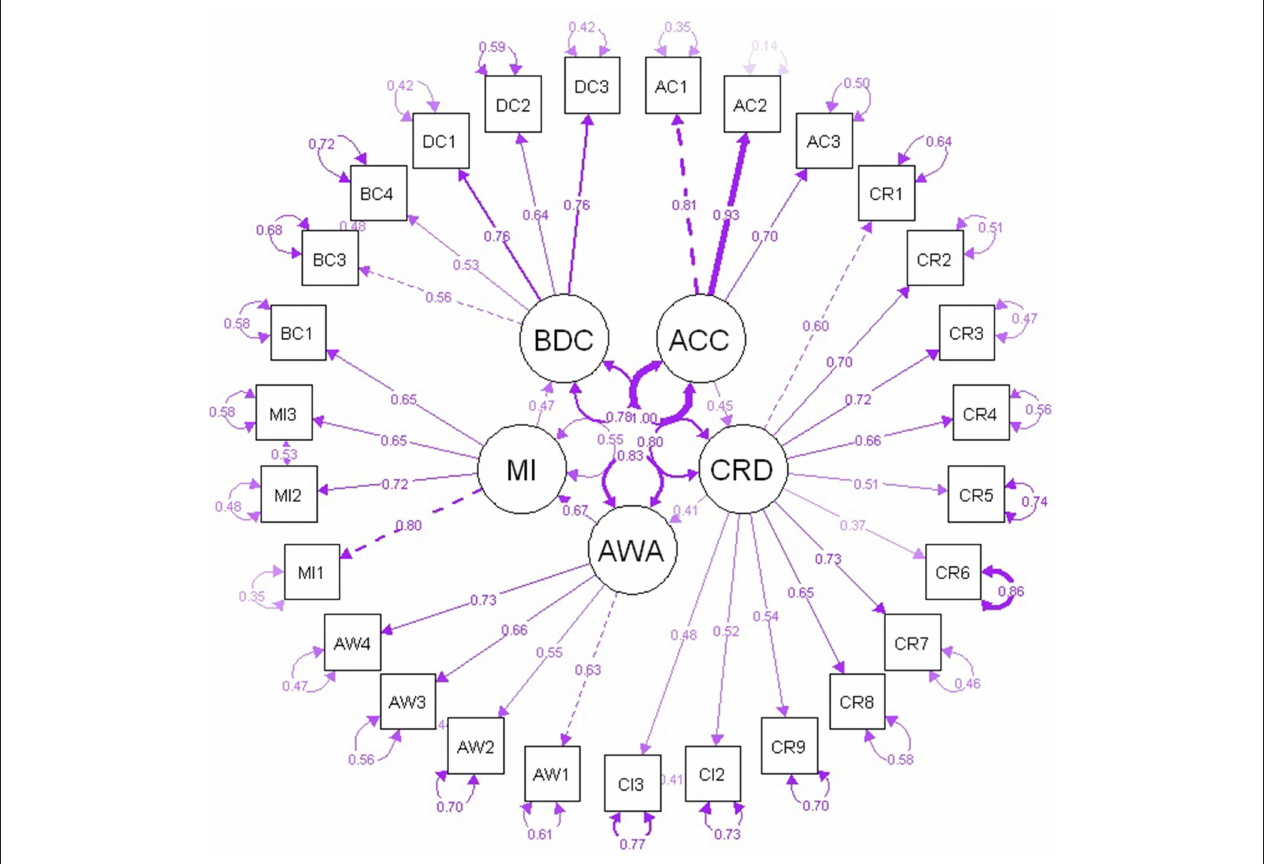
FIGURE 4 | Latent variable structural equation model of FLS with standardized factor loadings (reported on unidirectional arrows), error terms (circled values), and covariances (reported on bidirectional arrows). Factors in this figure are represented by the following key: ACC, Feedback Acceptance; CRD, Credible Source Challenge; AWA, Awareness from Feedback; MI, Motivational Intentions; and BDC, Behavioral Changes and Developmental Actions. See Appendix for a detailed key to items.